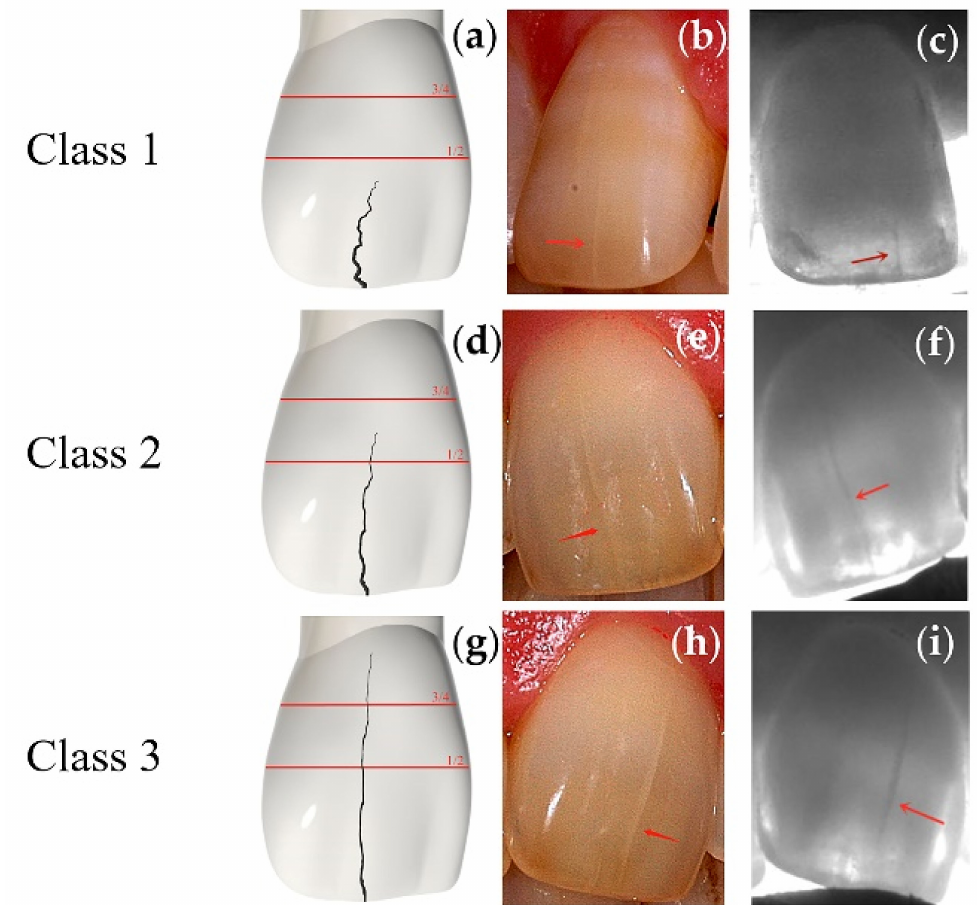
Figure 3. Simulated images, intraoral photos, and 850 nm Near-IR images for indicating the dif- ferences among the classifications. Red arrows indicate the cracks. ( a ) A simulated Class 1 central incisor crack. ( b ) An intraoral photo of a Class 1 crack on the maxillary central incisor under natural light. ( c ) The image of the tooth in Figure 3b under Near-IR. ( d ) A simulated Class 2 central incisor crack. ( e ) The intraoral photo of a Class 2 crack on the maxillary central incisor under natural light. ( f ) The image of the tooth in Figure 3e under Near-IR. ( g ) A simulated Class 3 central incisor crack. ( h ) An intraoral photo of a Class 3 crack on the maxillary central incisor under natural light. ( i ) The image of the tooth in Figure 3h under